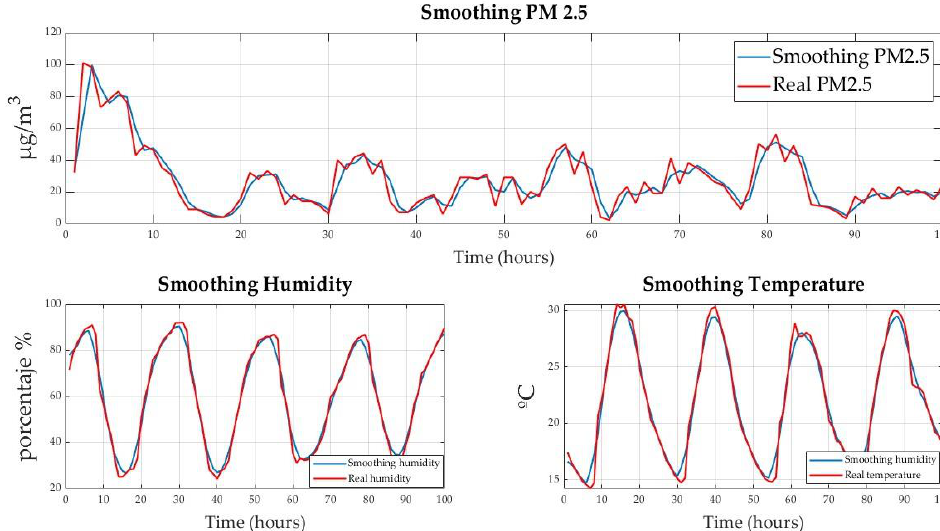
Figure 11. Dynamics of smoothed variables.